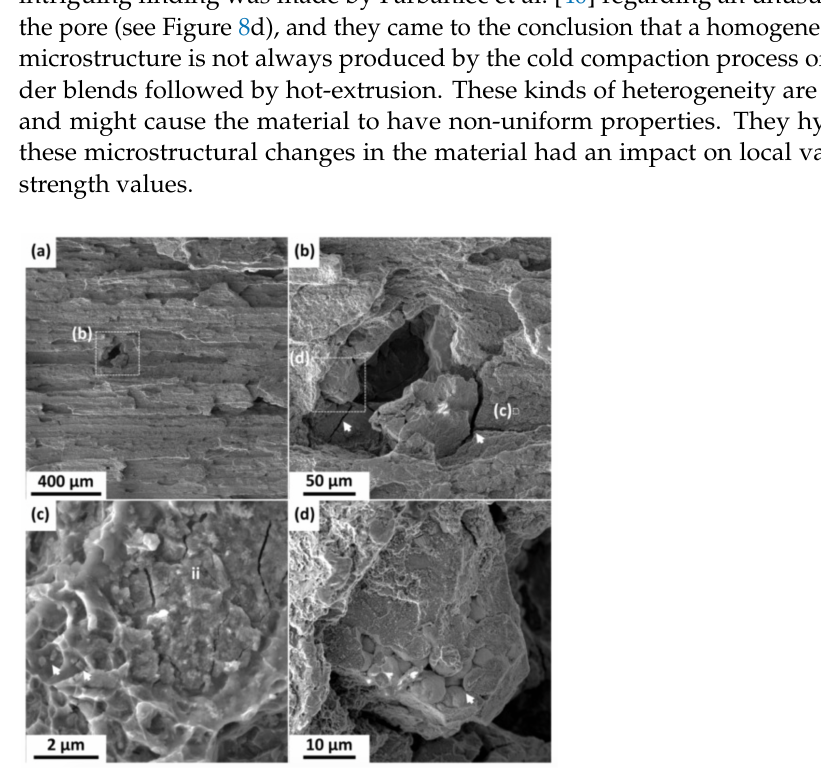
Figure 8. SEM micrographs of the fracture surface of the recovered AMX602 magnesium shock compressed to 1.7 GPa: ( a ) Magnified view of the striated spall surface, ( b ) closeup view of the void shown in subfigure ( a , c ) intermetallic Al2Ca compound surrounded by nanometer and micrometer size voids, ( d ) internal voids or microporosity in the microstructure of the as-processed Mg alloy